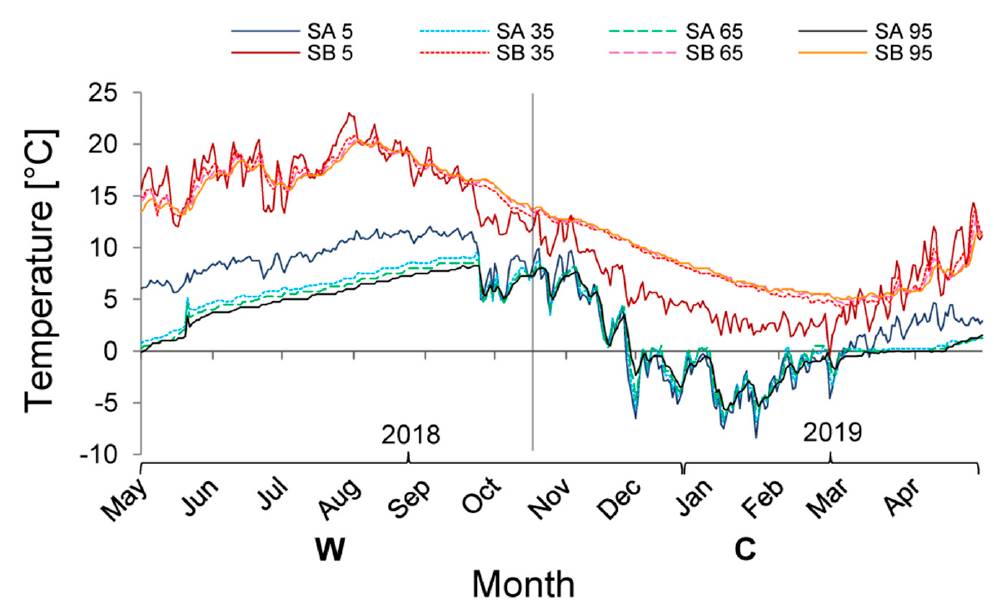
Figure 2. Temperature regime based on daily temperature means along the depth gradient at both sites in two different periods; W—warm period (May 2018–October 2018), C—cold period (October 2018–April 2019), 5, 35, 65, 95—soil/scree depth [cm]. The middle and deeper layers (35–95 cm) showed considerably smaller temperature fluctuations; however, at site SA during the cold period the variation was relatively high across the whole depth